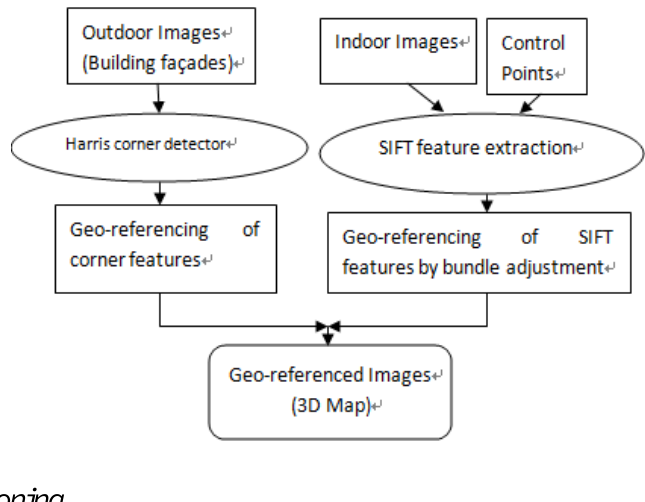
Figure 4. Flowchart for the mapping